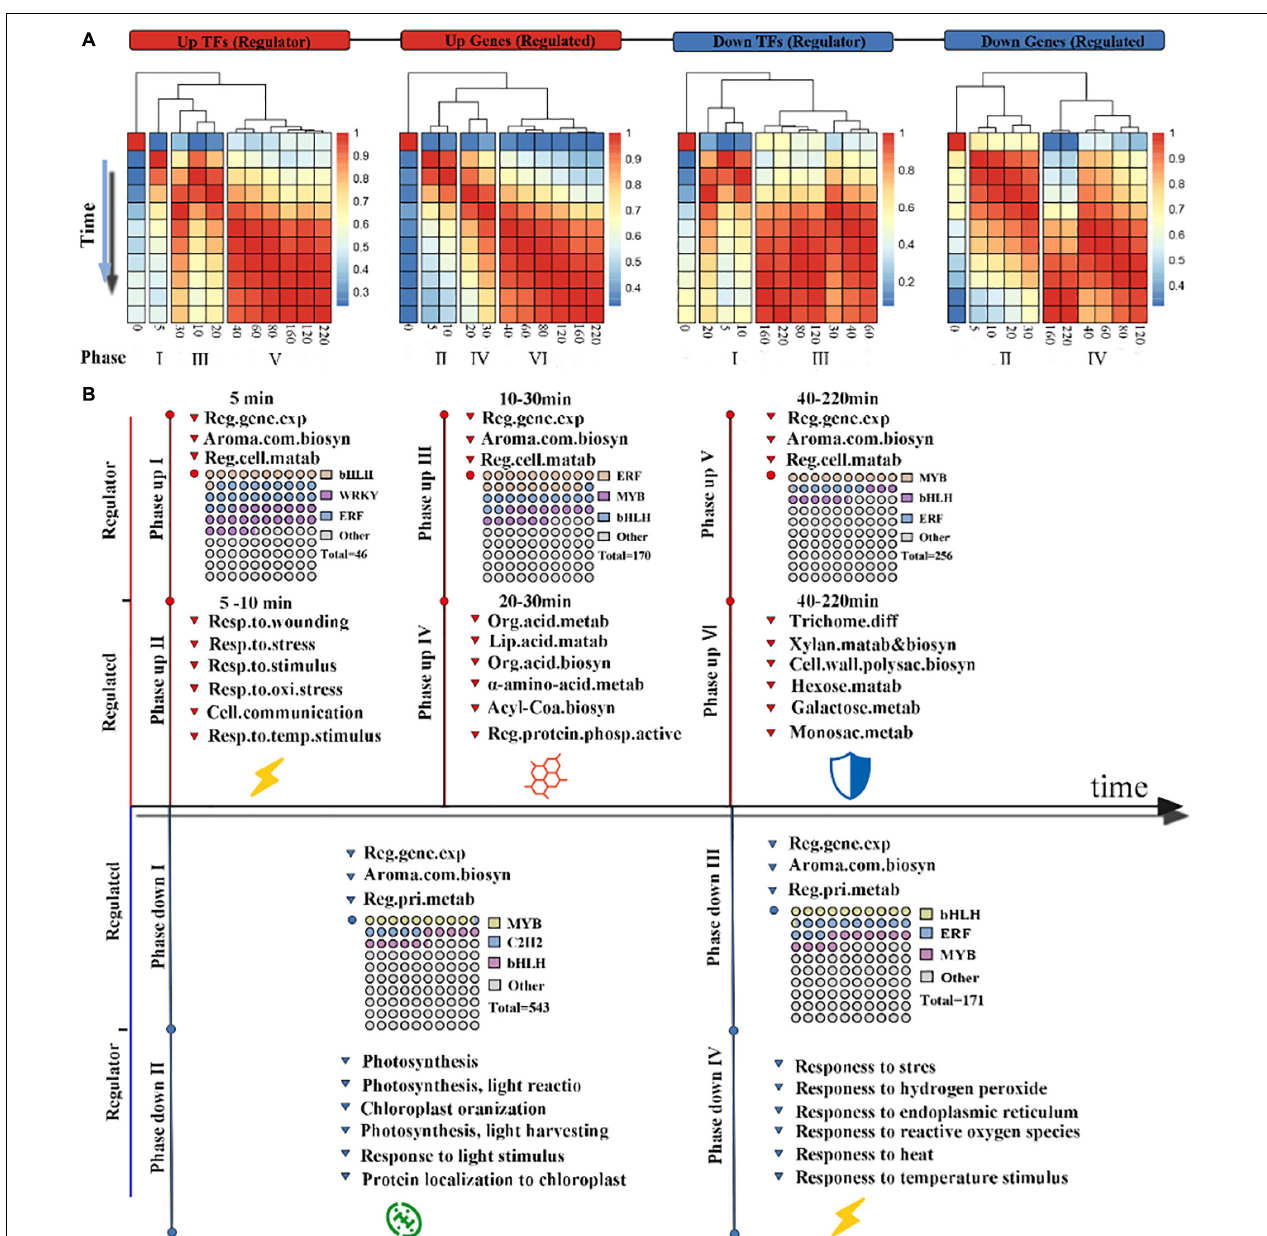
FIGURE 4 | Chronology analysis of the wounding-induced gene regulatory network: (A) various phases of wounding treatment induction. Differentially expressed genes were divided into four categories based on their annotation as a transcription factor or a structural gene and their expression patterns. The correlation matrix of gene expression between all pairs of time points was calculated by Pearson correlation and was further subjected to column clustering. Red and blue indicate high and low correlations, respectively. The time is in min. (B) Chronology chart of the wounding-induced gene regulatory network. The above part of the timeline represents the up-regulated phase, and the bottom part represents the down-regulated phase. The FDEGs in each phase were subjected to GO enrichment analysis. The waffle diagram shows the top 3 TF families in the gene